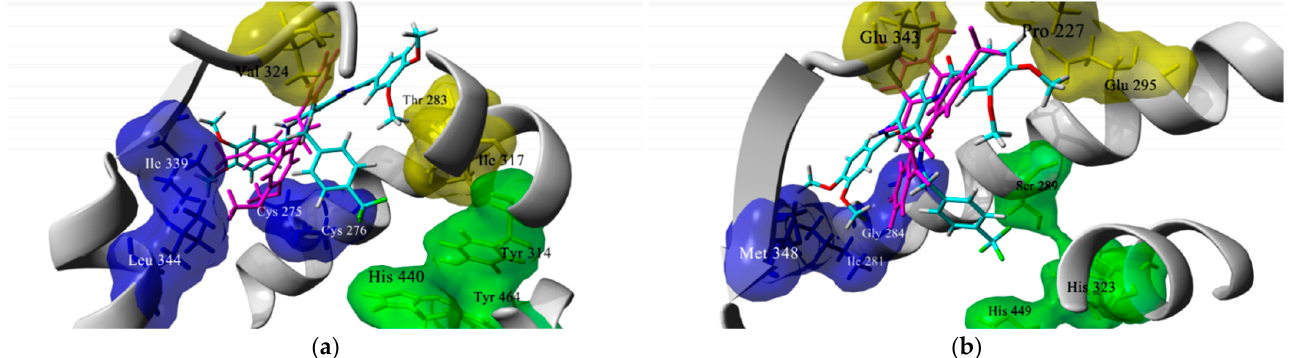
Figure 3. Predicted docking poses for compound 48a (magenta) and 1b (CPK, carbon atoms in cyan) in their complexes with ( a ) PPAR- α ; ( b ) PPAR- γ . Green and blue-colored residues correspond to the binding pockets of known dual PPAR partial agonists, and yellow residues describe additional binding sites. See discussion section for details.